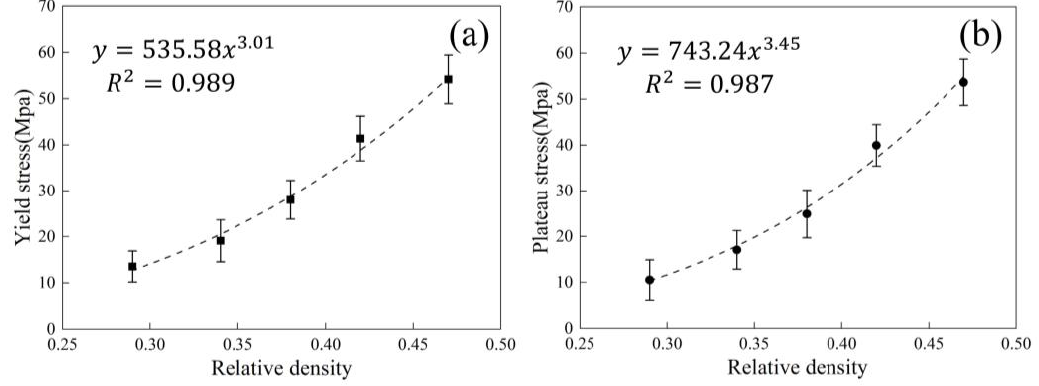
Figure 13. ( a ) Yield stress and ( b ) plateau stress of composites at different relative densities.